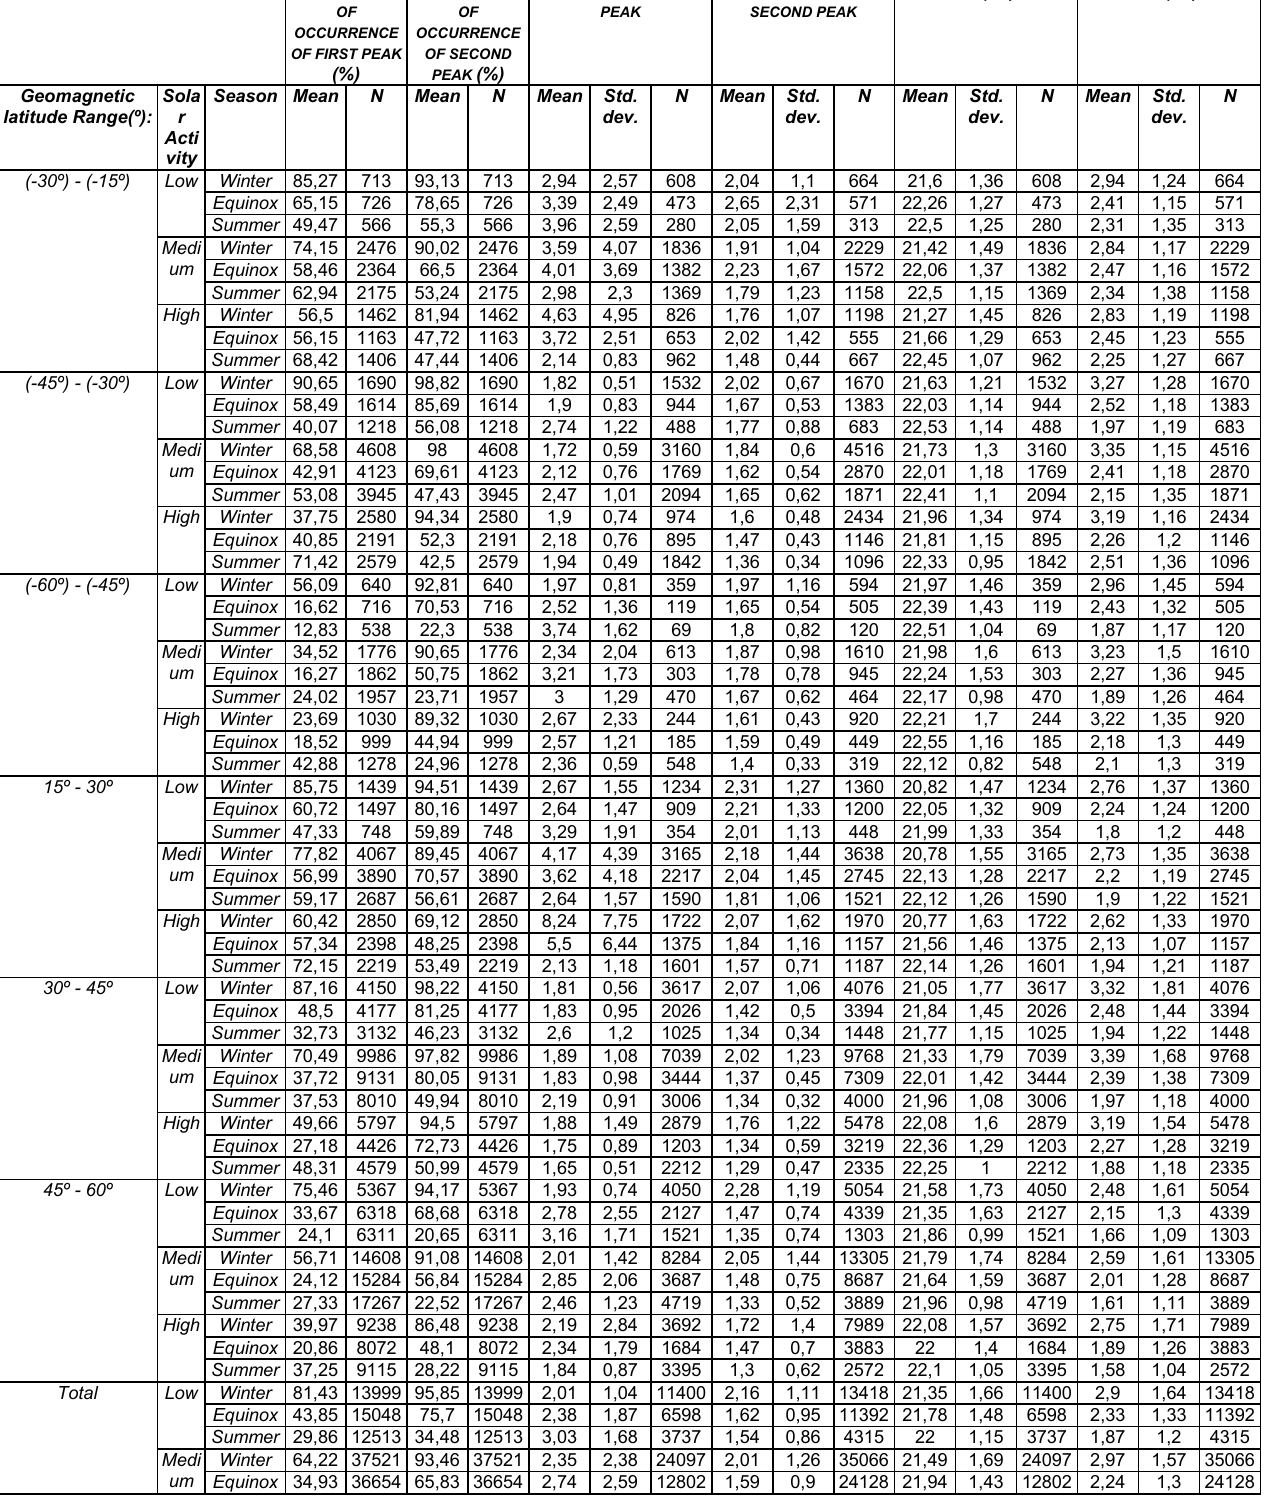
Table 2. Numerical results: Mean, standard deviation and number of valid cases for each variable and condition. P